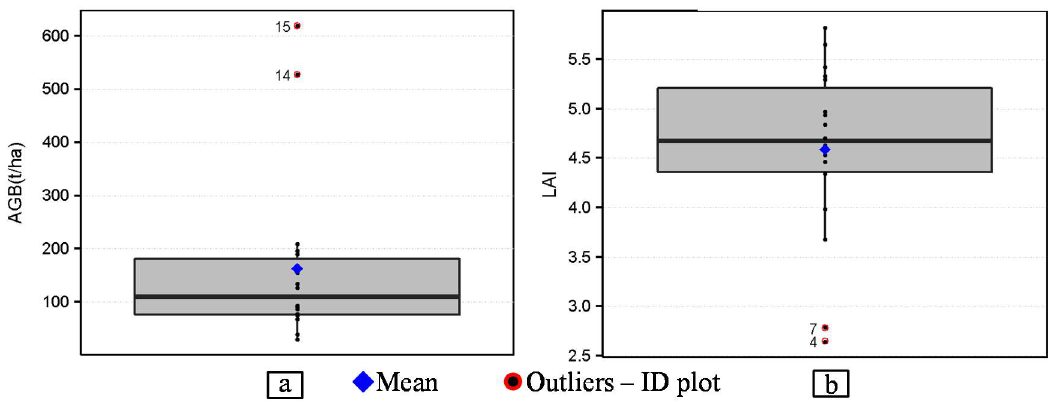
Figure 6. Boxplot graphic: ( a ) Above Ground Biomass (AGB) e ( b ) Leaf Area Index (LAI).